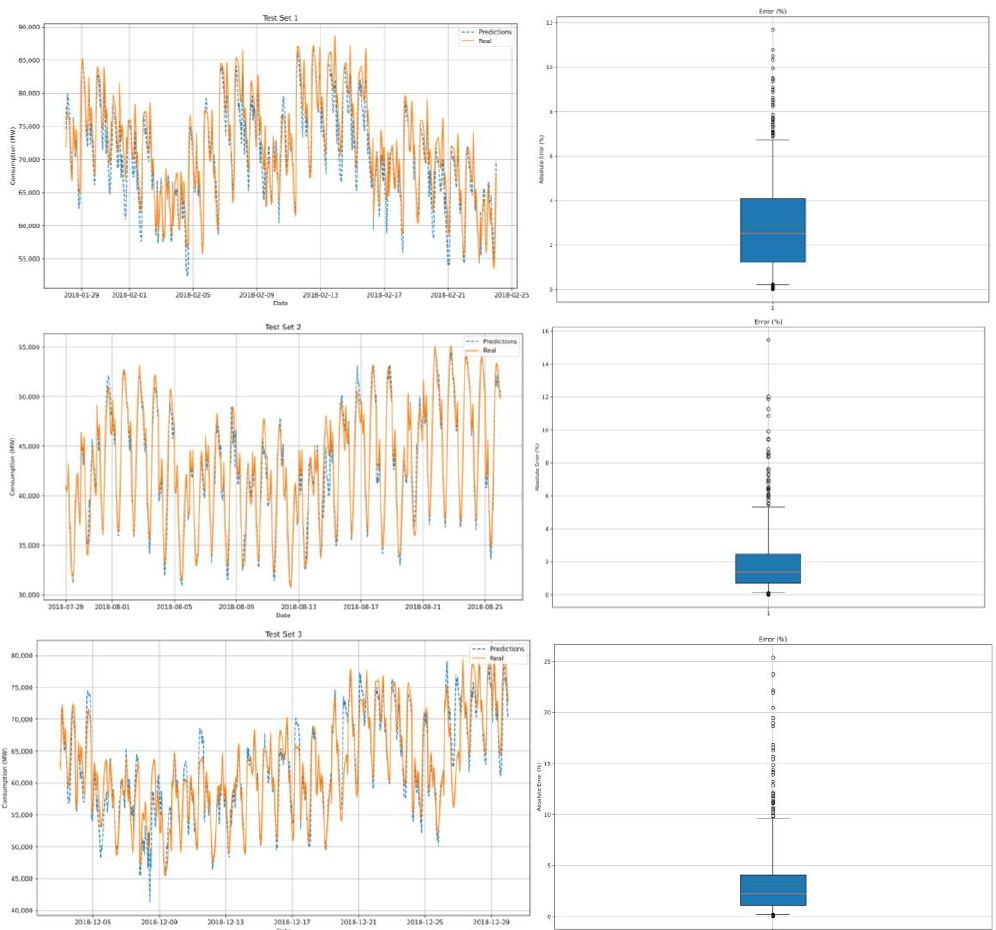
Figure 8. Performance of the power foecasting model on the three different test sets. ( Left column) Real and prediction of the power consumption in the three different testing sets. ( Right column) Box-Plot of the absolute error in each test set. The coloured lines within the box represent the mean (dashed green) line and the median (orange)